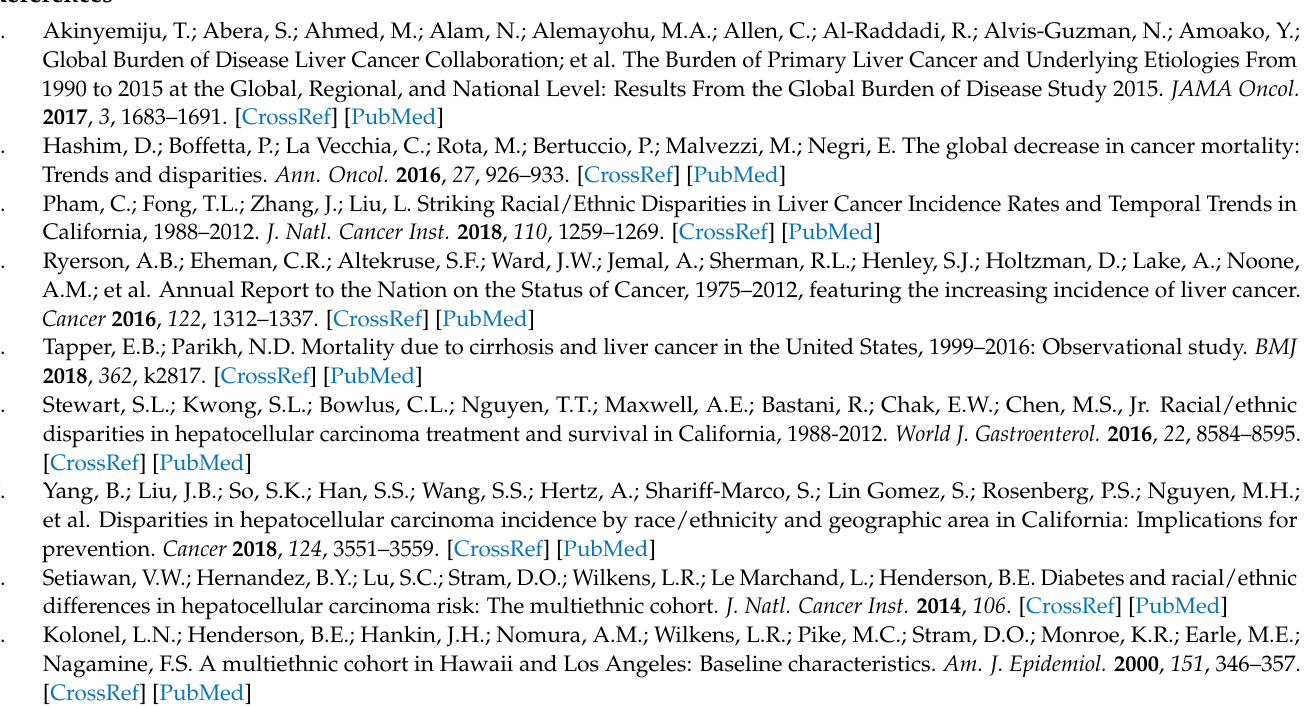
race/ethnicity. Table S2: Association of race/ethnicity and other factors with HCC-related mortality. Figure S1: Overall (all-cause mortality) survival by underlying etiology (Log-rank p -value =